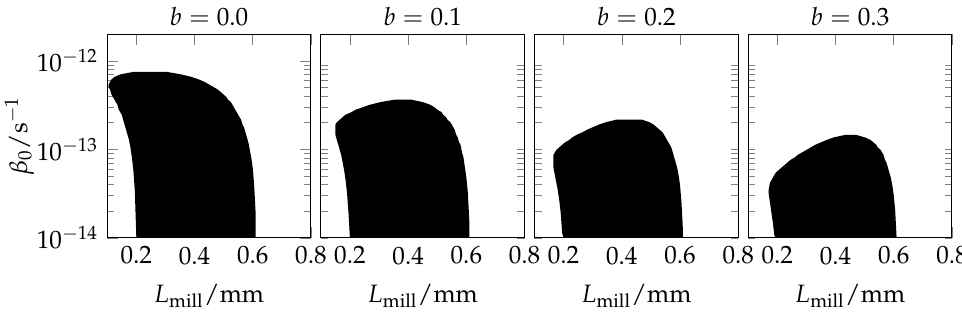
Figure 7. Stable (white) and unstable (black) regions for variations of b . The layering growth rate G is directly proportional to the binder injection rate m inj . Therefore, increasing the latter results in faster particle growth and more particles in the oversized fraction, preventing the formation of the stable equilibrium for mill diameters smaller than 0.2 mm due to the mechanism described above described above. Decreasing m inj has the inverse effect as presented in Figure 8. The lower growth rate allows for the withdrawal of most particles in the product region, in turn minimizing the oversized fraction such that no new mode of milled particles is created.